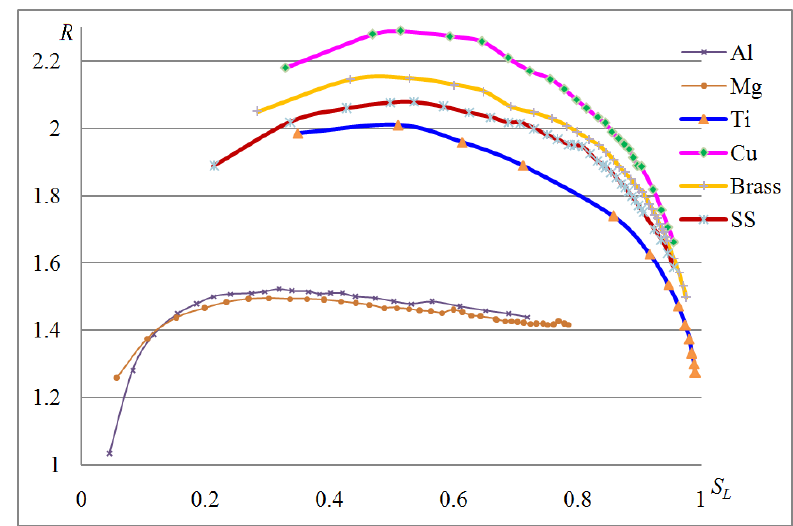
Figure 9. DE-XRT S L - R calibration curve of one channel.